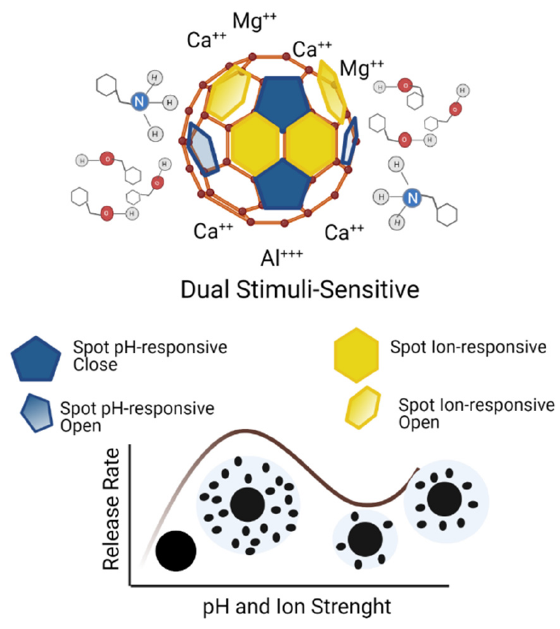
Figure 2. Schematic illustration for dual stimuli-responsive and diffusion release profile.